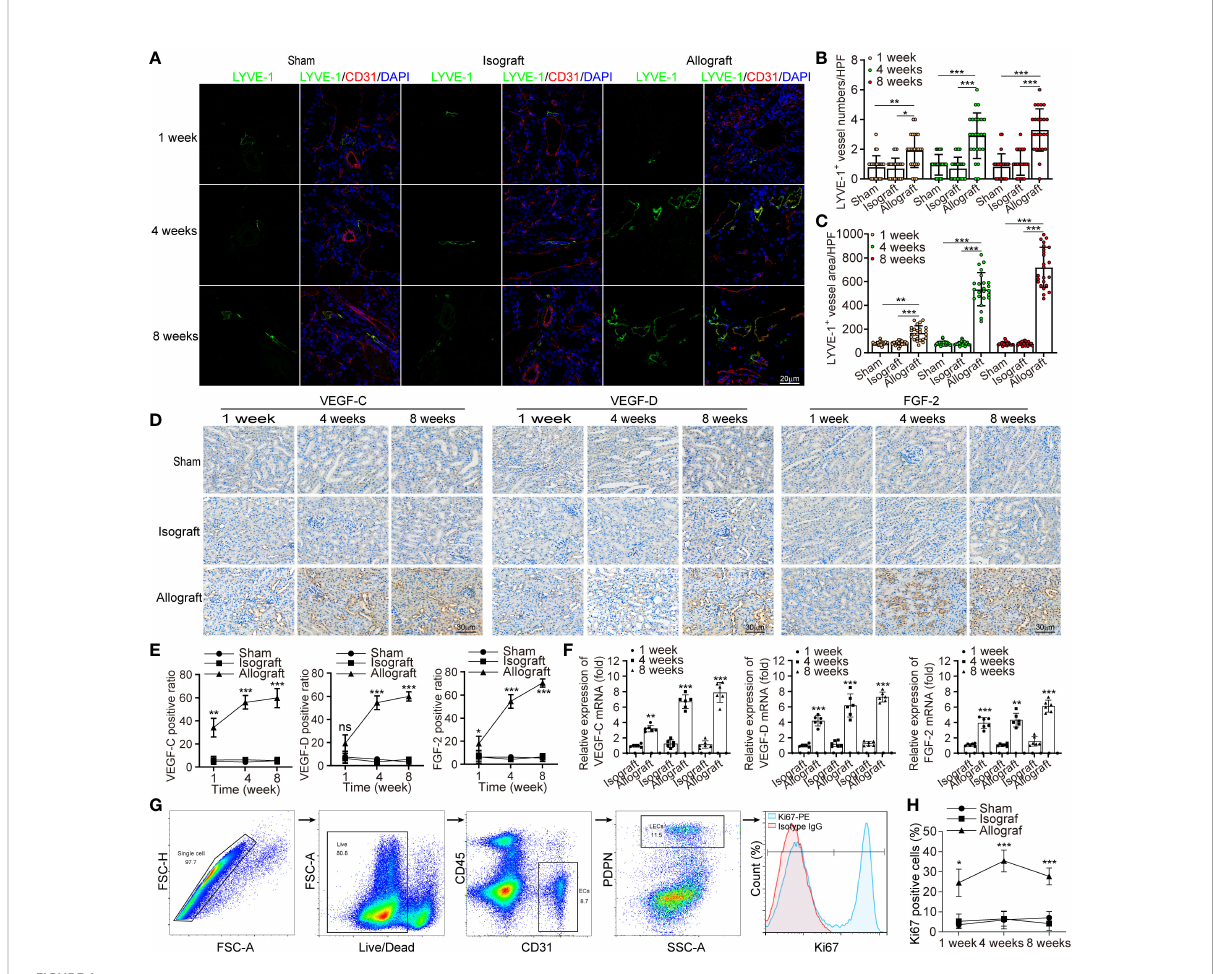
FIGURE 1 Chronic rejection is associated with lymphangiogenesis in renal allograft. (A) Representative immuno fl uorescence images of LYVE-1, CD31, and DAPI within sham (n=6 mice), isograft (n=6 mice) and allograft (n=6 mice) kidneys at 1, 4 and 8 weeks respectively. (B, C) Numbers and area counting of LYVE-1 + vessels in high-power fi eld (HPF) at 1, 4 and 8 weeks respectively. (D) Immunohistochemistry of VEGF-C, VEGF-D and FGF-2 expression within sham, isograft and allograft kidneys at 1, 4 and 8 weeks respectively. (E) Positive ratio of VEGF-C, VEGF-D and FGF-2 within sham, isograft and allograft kidneys at 1, 4 and 8 weeks respectively. (F) Relative mRNA expression of VEGF-C, VEGF-D and FGF-2 by qRT-PCR within isograft and allograft kidneys at 1, 4 and 8 weeks respectively, using sham as a reference. (G) Live single CD45 - PDPN + CD31 + LECs isolating from renal allograft by gating technology via fl ow cytometry, and the population of Ki67 + cells. (H) The ratio of Ki67 + cells in PDPN + CD31 + LECs within sham, isograft and allograft kidneys at 1, 4 and 8 weeks respectively. *P < 0.05, **P < 0.01, ***P < 0.001. Values are mean ±